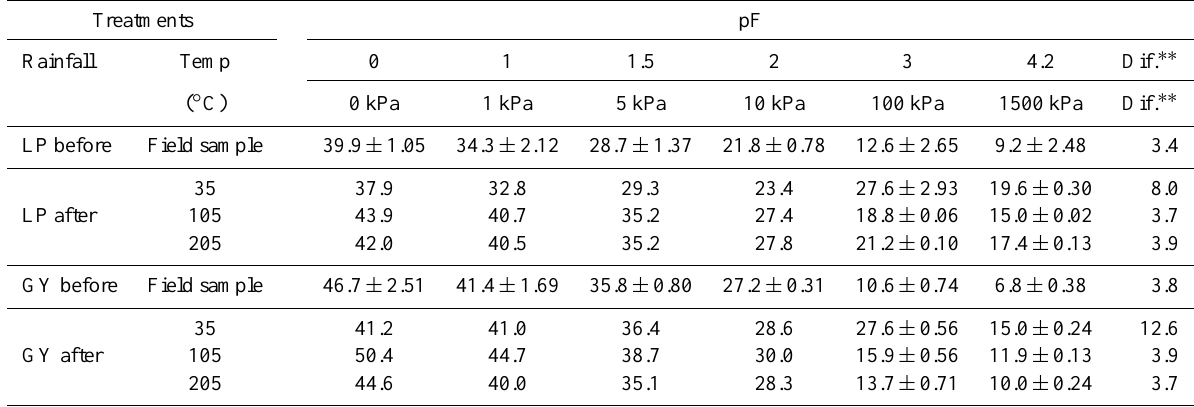
Table 2. Mean value and standard deviation of the values of the pF (the base 10 logarithm of the water potential in centimeters). LP and GY before and after the rainfall simulation. ( ∗∗ ) Difference between pF 4.2 and pF 3.